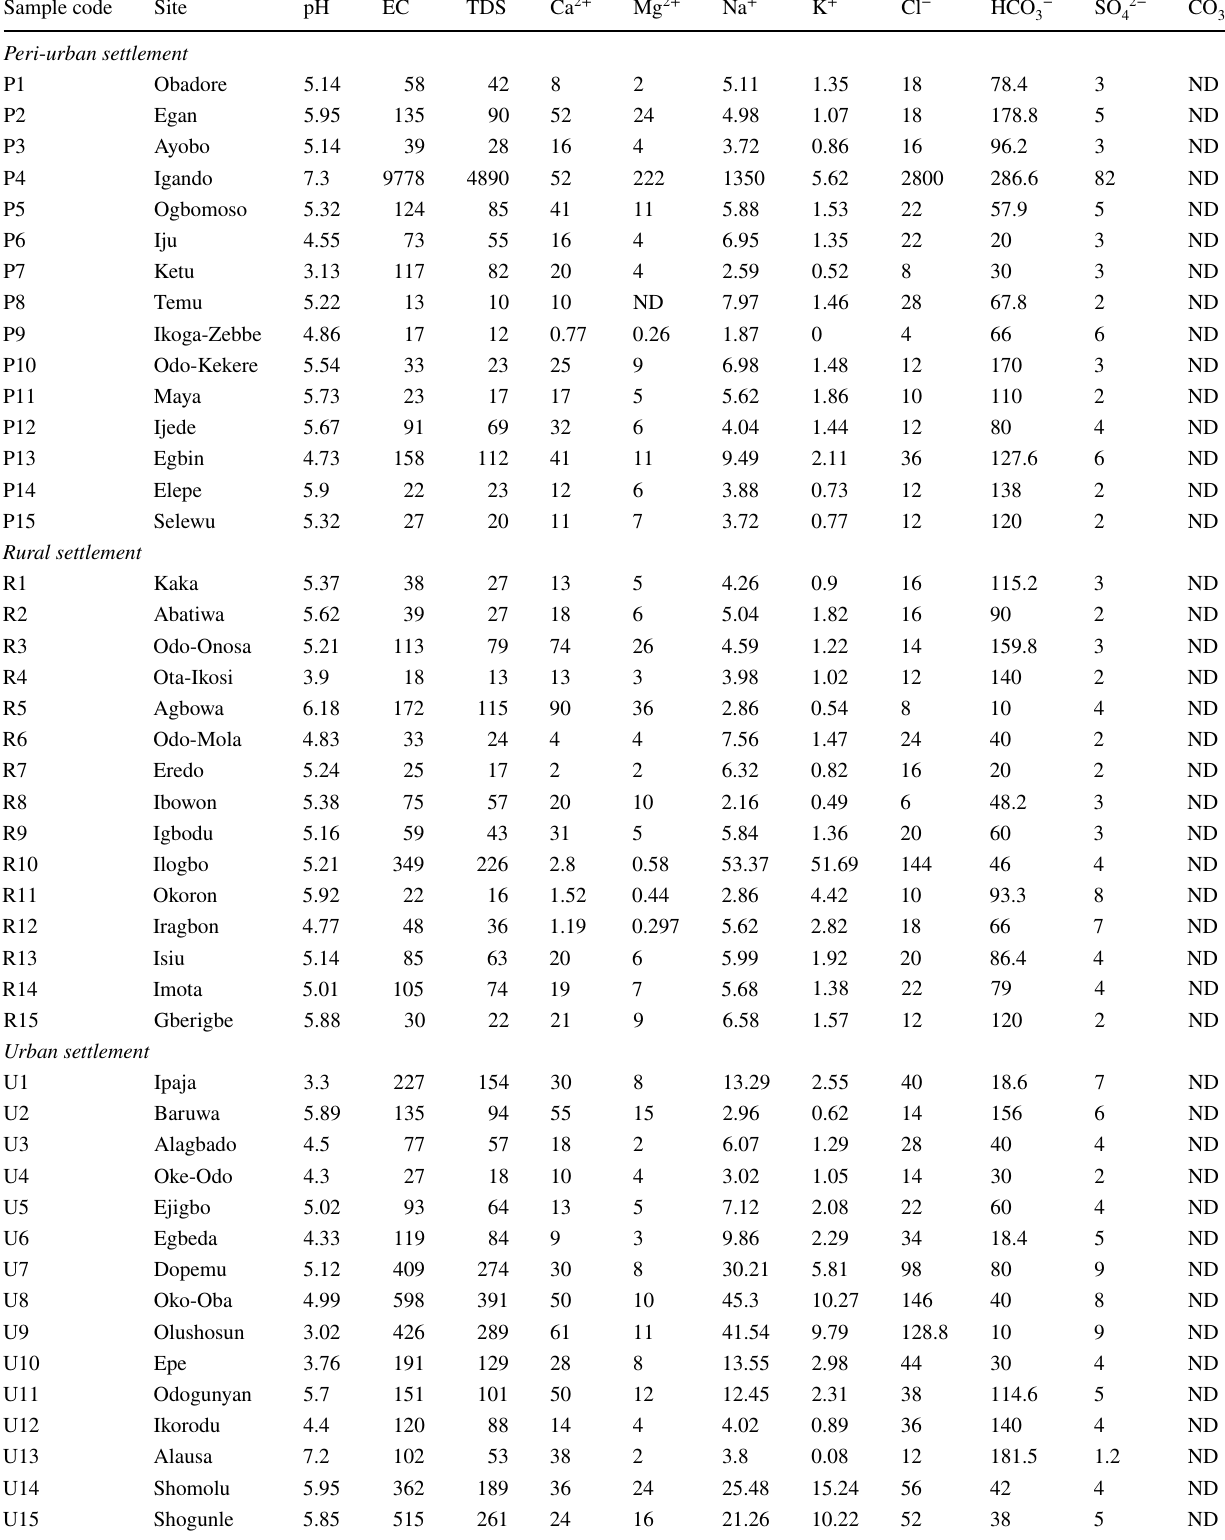
Table 2 Physicochemical parameters of groundwater in the dry